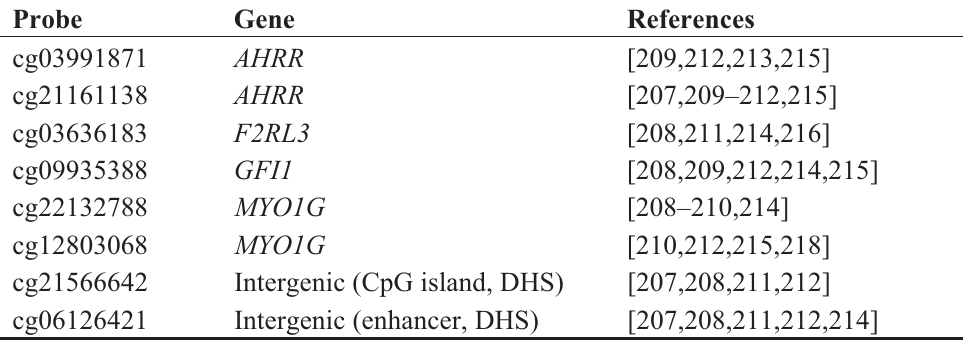
Table 4. Other HM450 probes with significant correlations with smoking in at least four studies. Probes are included if found to be significantly associated with smoking in at least four independent studies. DHS, DNAse hypersensitive site, indicative of regulatory